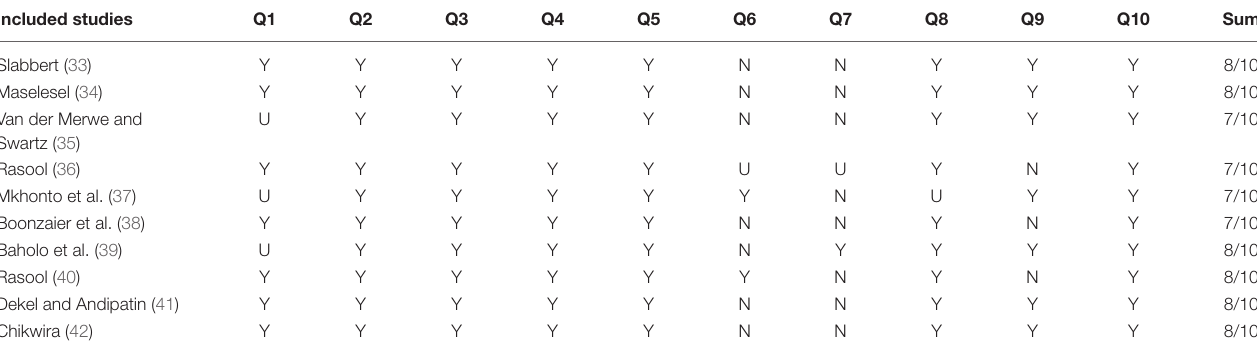
TABLE 1 | Critical appraisal of included